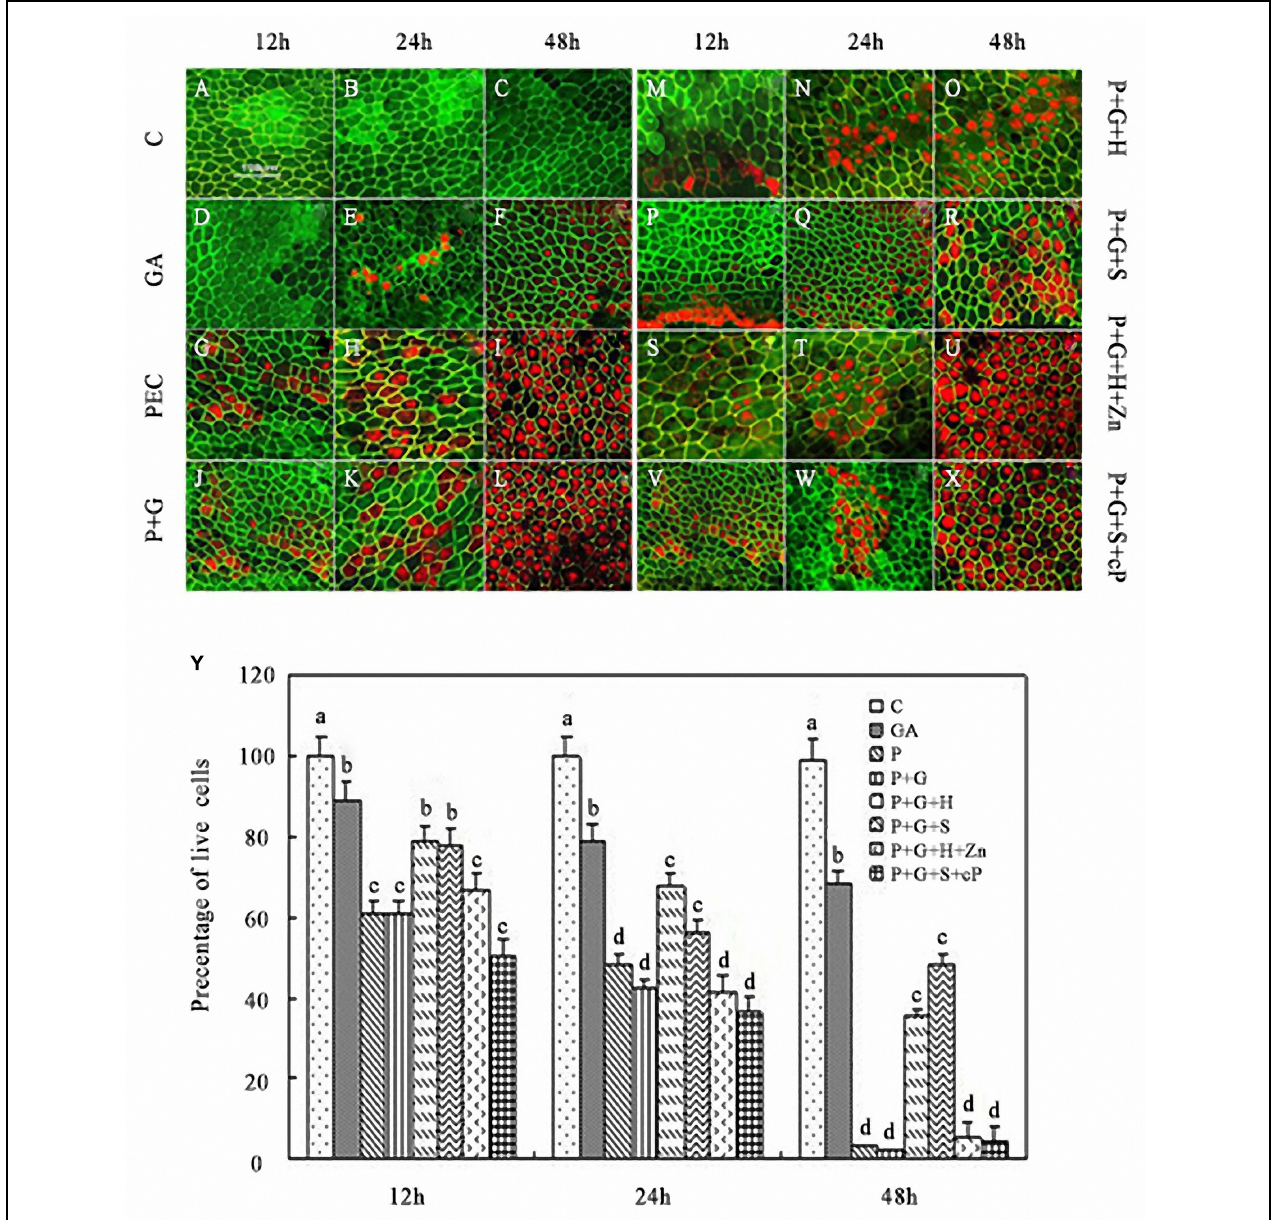
FIGURE 4 | Increase or decrease in HO-1 gene expression and HO activity related to the acceleration or delay of GA-triggered PCD in rice aleurone layers under drought stress. Aleurone layers were incubated in FDA (green, live cells) and FM-4-64 (red, dead cells) prior to image capture. Aleurone layers treated with or without 20% PEG (P), 50 μ M GA (G), 1 μ M Ht (H), 200 μ M SNP (S), 10 μ M ZnPPIX (Zn), and 200 μ M cPTIO (cP) alone or in combination for 12, 24, and 48 h, respectively. A sample with distilled water treatment was used as control (C). Images of cells showing fluorescently labeled aleurone layers were captured (A–X) . Cell survival rate was also quantified (Y) at 12, 24, and 48 h. Scale bar, 100 μ m. Mean values were calculated from at least three independent experiments, bars with different letters indicated significant differences at the 0.05 level, according to Duncan’s multiple